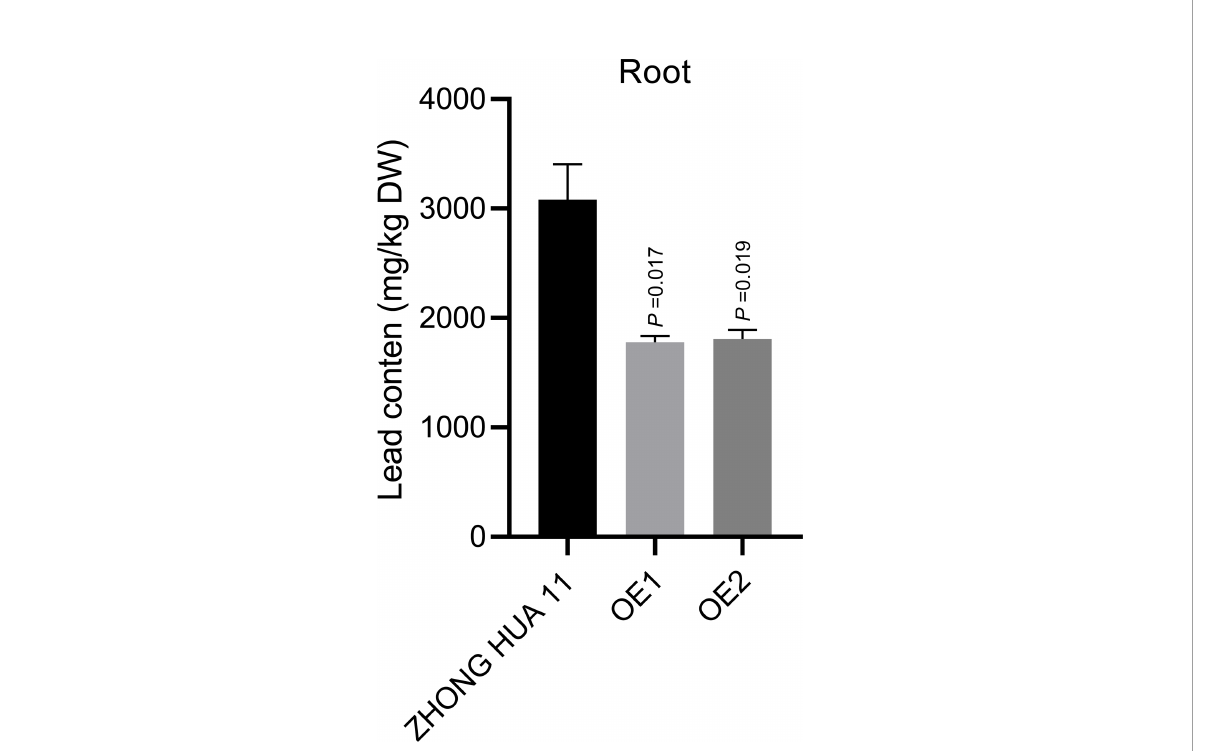
FIGURE 6 Pb content in the roots of ZmbZIP107 -overexpressed lines (OE1 and OE2) and ZHONG HUA 11. DW represents dry weight of